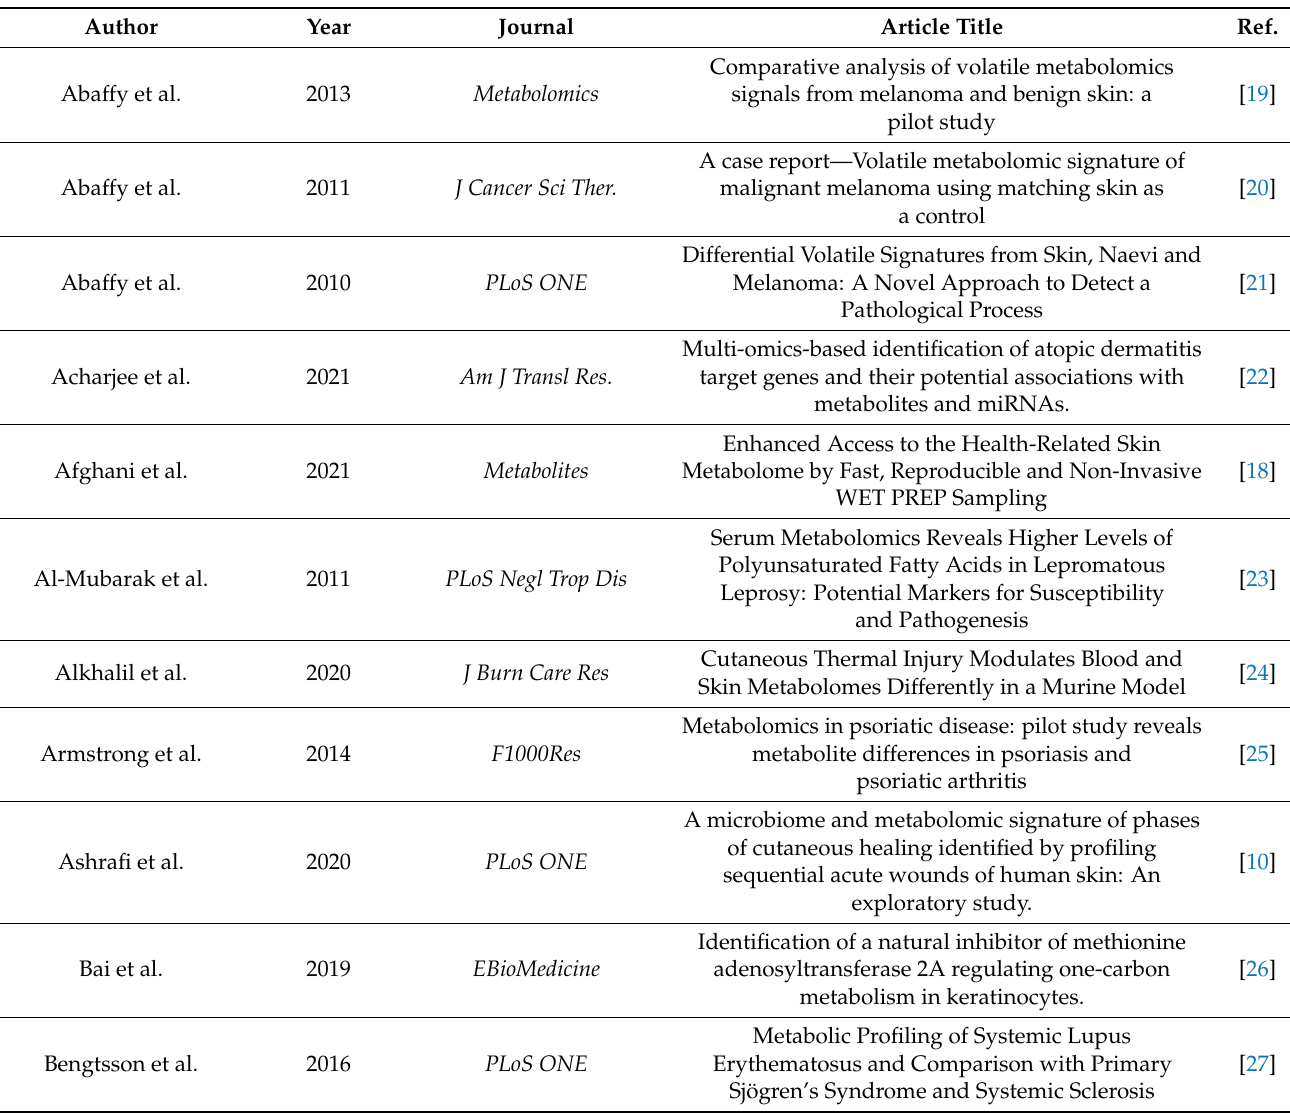
Table 1. List of the 97 papers retrieved with our search. Authors have been listed in alphabetical order. Journal names are abbreviated according to MedLine